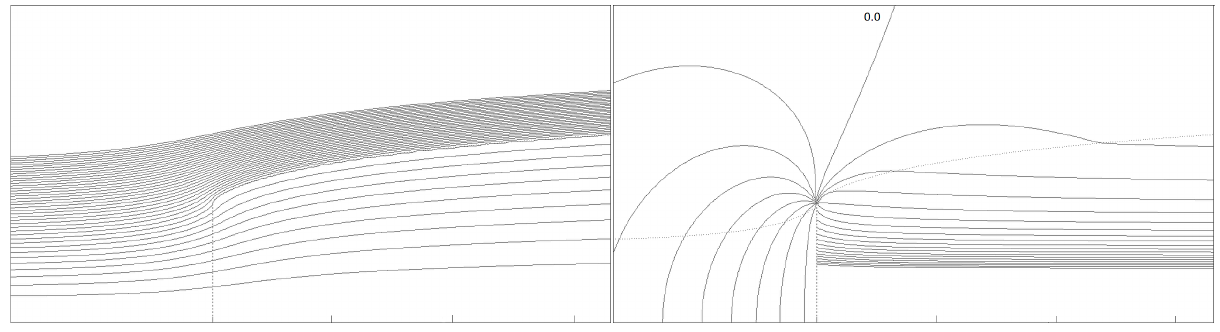
ρU 2 ) = − 0 . 8888 and λ = 0 . 731. Isobars close to 0 2